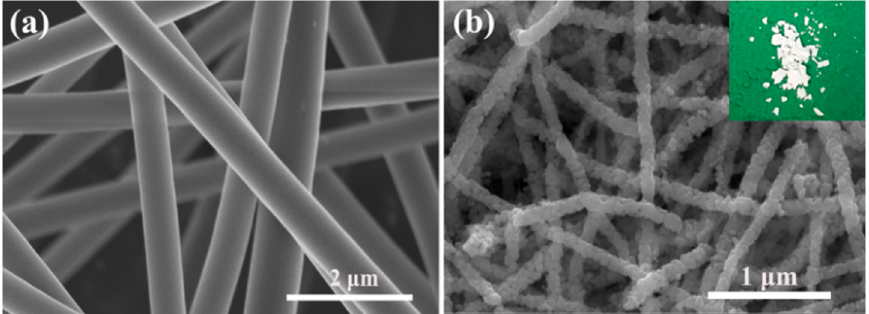
Figure 3. SEM images of as-prepared samples: ( a ) precursor ZnO NFs and ( b ) ZnO NFs. The inset is the digital image of synthesized ZnO NFs material.